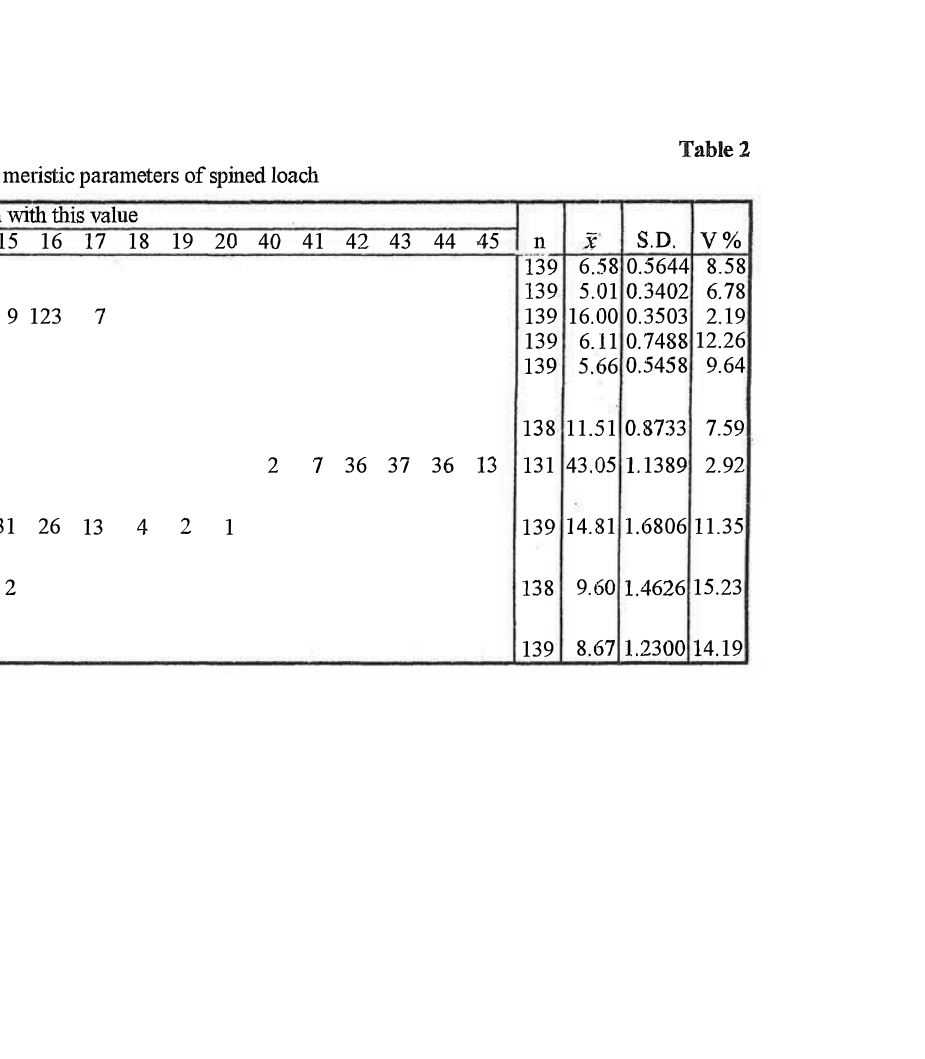
Values of meristic parameters of spined